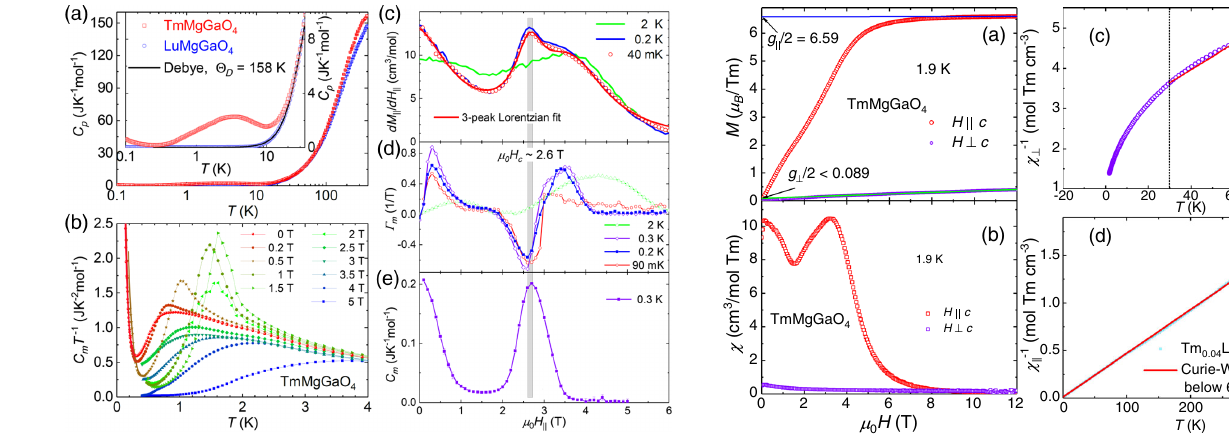
FIG. 8. (a) Heat capacity of the TmMgGaO 4 and LuMgGaO 4 FIG. 9. Field dependence of (a) magnetization ( M ) and (b) sus- single crystals measured at 0 T. The inset presents an enlarged ceptibility ( dM=dH ) of TmMgGaO 4 measured in fields both plot of the low- T data with the black line showing the Debye heat- parallel and perpendicular to the c axis. The data were measured 158 K). (b) Magnetic heat capacity of capacity fit ( Θ in the same vibrating sample magnetometer PPMS using the D ¼ TmMgGaO 4 measured at selected fields. The phonon or lattice same single crystal of TmMgGaO 4 (96.90 mg). The colored lines contribution was subtracted by the heat capacity of the non- in (a) represent the linear fits above 8 T. We stopped the M ⊥ magnetic LuMgGaO 4 . The observed upturns below ∼ 0 . 3 K are measurement at 12 T, as the force acting on the crystal may fitted by considering the nuclear spin contributions. (c) Field become too large, thus breaking the crystal itself or the sample =dH dependence of the susceptibility ( dM ) with the red line holder [39]. (c) Temperature dependence of the susceptibility k k showing the three-peak Lorentzian fit. (d) Field dependence of measured in the field of 0.1 T applied perpendicular to the c axis. the magnetic Grüneisen ratio measured at 0.09, 0.2, 0.3, and 2 K. The straight red line is a guide to the eye demonstrating that no (e) Field dependence of the heat capacity measured at 0.3 K. Curie-Weiss behavior is observed between 30 and 60 K [the temperature range where the magnetic entropy in Fig. 2(e) shows a plateau that indicates a paramagnetic regime not affected by spin-spin correlations and CEF excitations to higher levels]. (d) Temperature dependence of the dc susceptibility measured on the single crystal of Tm 0 Lu 0 MgGaO 4 along the c axis. The . 04 . 96 red line shows the Curie-Weiss fit to the data between 30 and 60